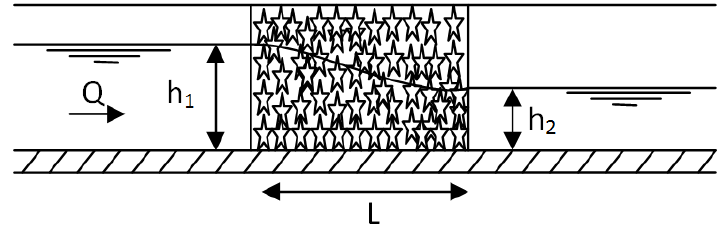
Figure 5. Sectional elevation in the canal where star media was installed. Table 1. The operational conditions applied through the experimental study. Runs Length (m) Flow Rate (L · s − 1 ) Measured Parameters Calculated